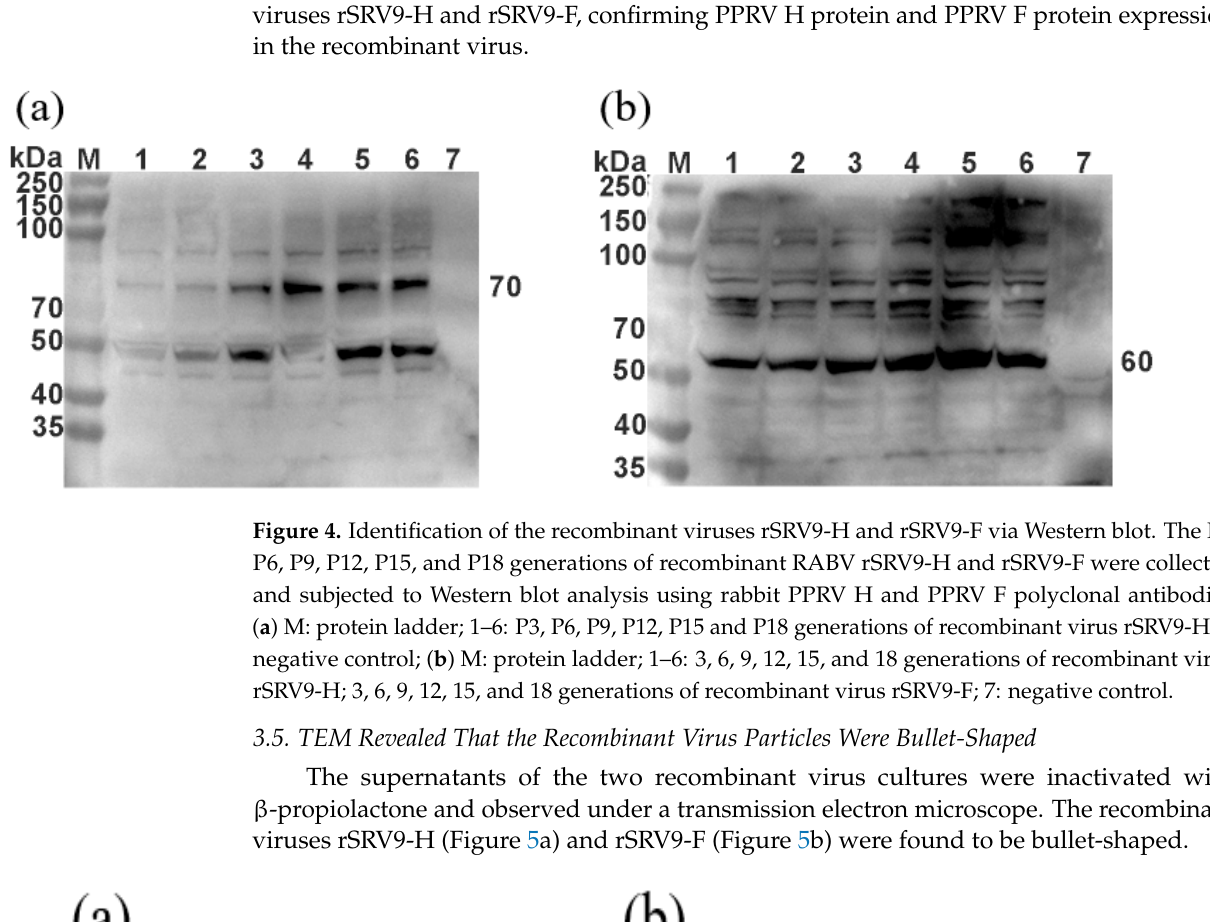
Figure 3. Identification of recombinant viruses rSRV9-H and rSRV9-F by indirect immunofluores- cence. The viruses were labeled with rabbit anti-PPRV H and PPRV F polyclonal antibody serum and an FITC-labeled goat anti-rabbit IgG antibody and observed under a fluorescence microscope. ( a ) Recombinant virus rSRV9-H, ( b ) negative control, ( c ) recombinant virus rSRV9-F, ( d ) negative control.